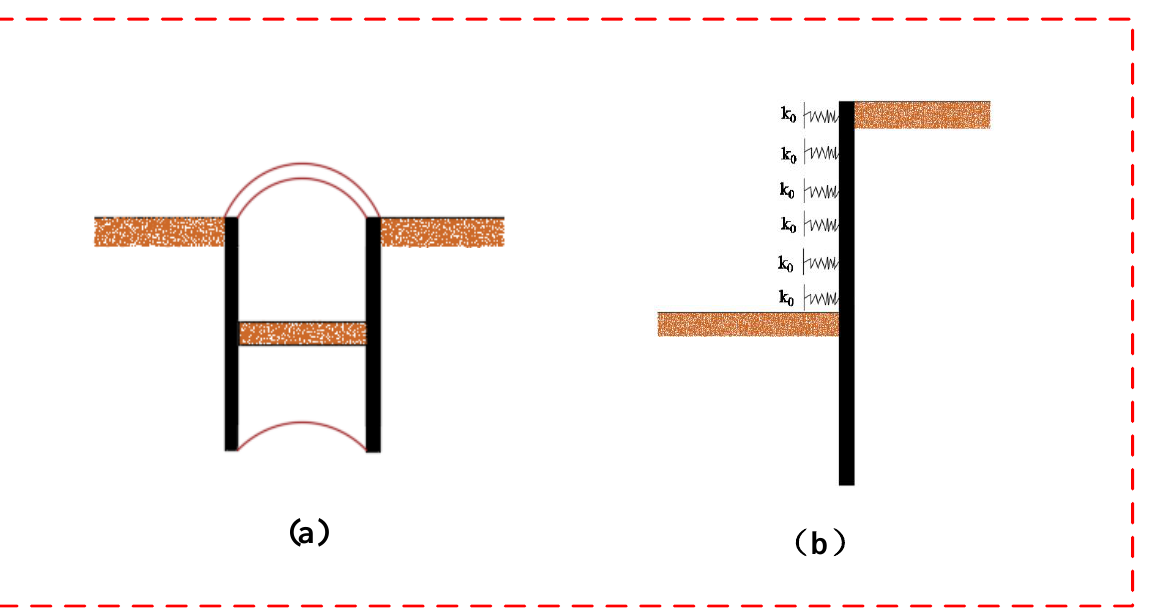
Figure 4. Schematic diagram of calculation of underground diaphragm wall support: ( a ) schematic diagram of support; ( b ) schematic diagram of arch effect conversion.